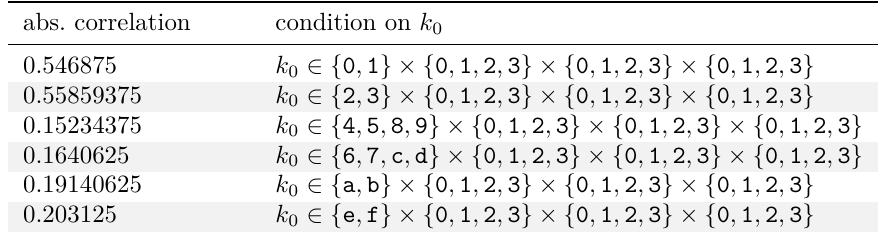
Table 3: Fixing the second round key k 1 = ( 0 , 0 , 0 , 2 ), this table shows all possible values for the absolute correlation of the approximation ( 8 , 8 , 8 , 8 ) → ( 8 , 8 , 8 , 8 ) over E G 00 , G for k 0 from the set of weak keys WK 00 .